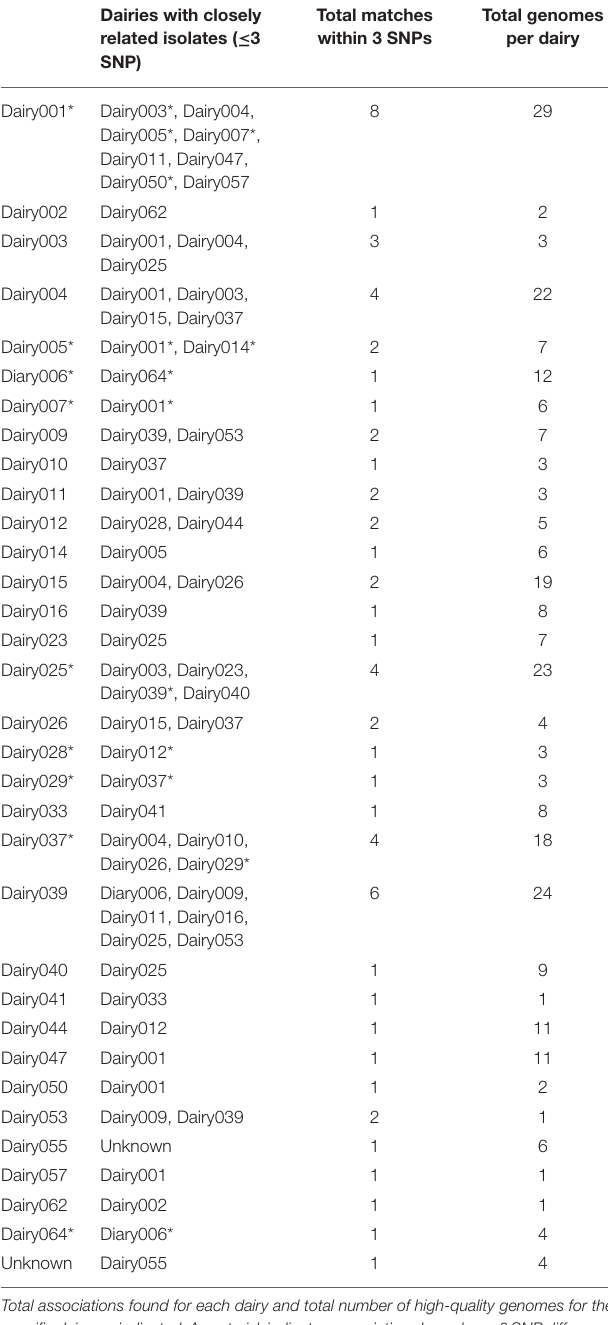
TABLE 4 | Possible epidemiological associations between BCA dairies based on isolates with a difference of ≤ 3 SNP. Dairies with closely related isolates ( ≤